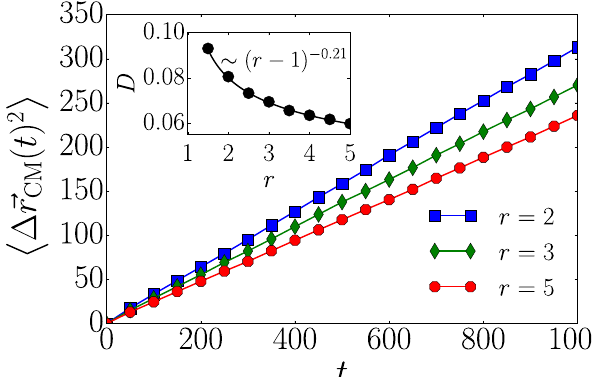
 r t ( ) CM 2 as a function of  r t ( ) CM 2 suggests that the confined epidemic